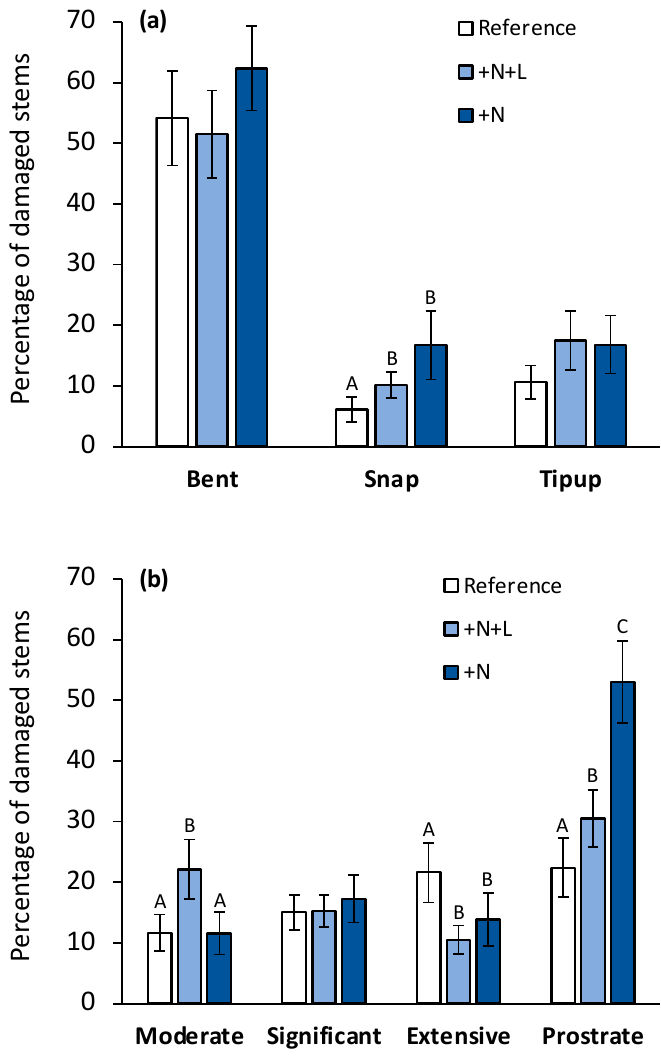
Figure 2. Stem damage from a windstorm across the reference, nitrogen fertilized (+N), and nitrogen and lime fertilized (+N+L) treatments in the LTSP Experiment: ( a ) Percentage of tree stems damaged by damage type; ( b ) Percentage of tree stems damaged by damage severity. Bars and error bars represent the empirical means and one standard error, respectively. Differences in capital letters within either a type or severity group denote significant differences ( p < 0.05) between treatments, determined by bootstrap hypothesis tests.